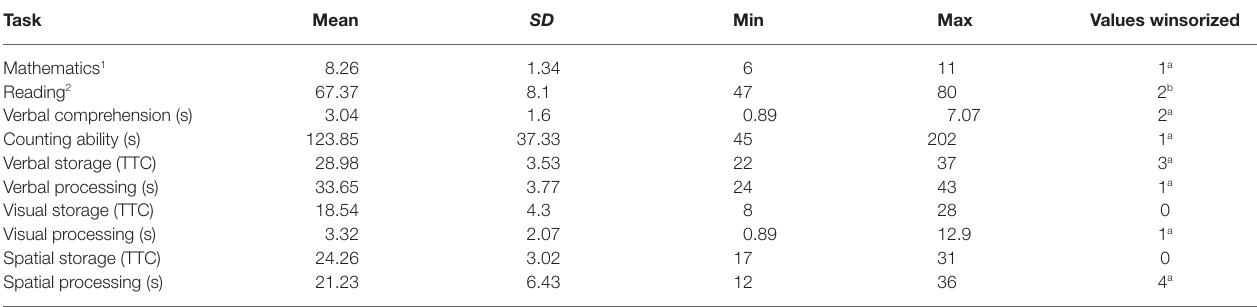
TABLE 3 | Mean and standard deviations for all cognitive and academic measures. Task Mean